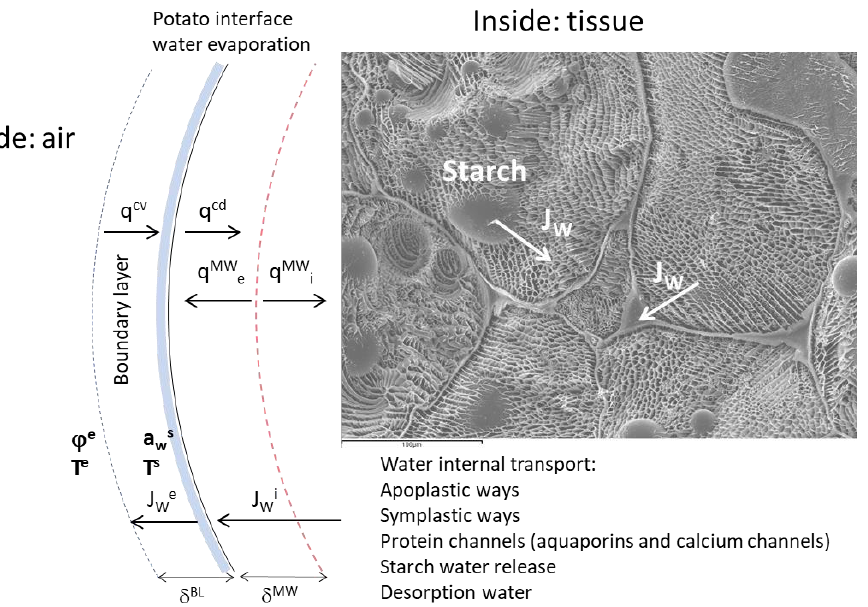
Figure 2. Scheme of heat and water mass transport mechanisms in a combined hot air drying (HAD) and MW drying process, where q represents heat, J W represents water flux, ϕ e is the drying relative humidity, T e is the drying temperature, T s is the surface of the sample temperature, a ws is the water activity of the sample in the surface, the superscript MW means microwave, CV means convective and cd is conduction.